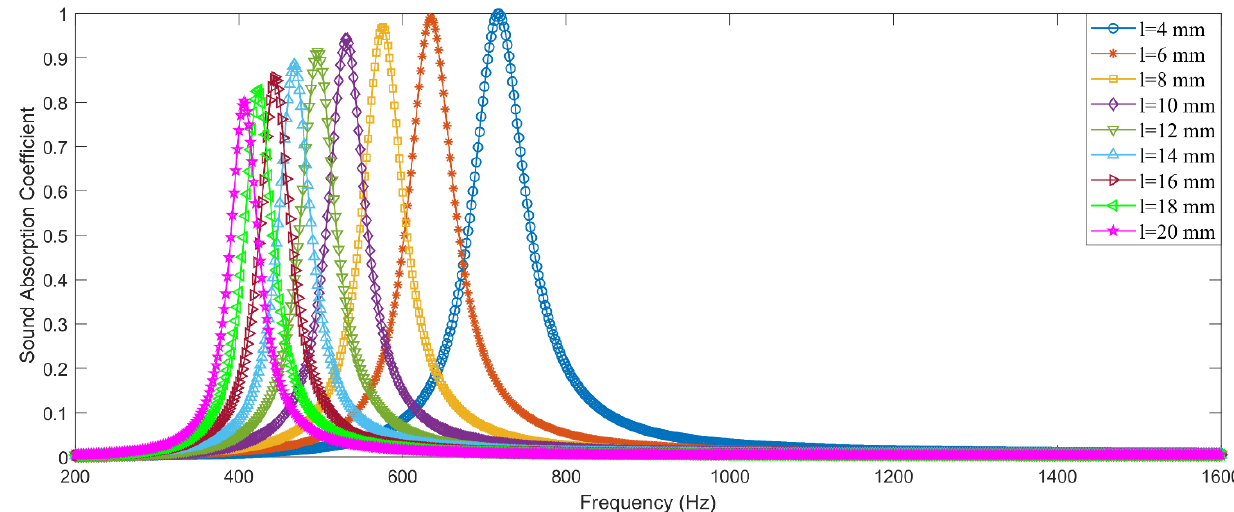
Figure 4. Distributions of theoretical sound absorption coefficients of single resonator along with increase in length of the aperture obtained by two–dimensional equivalent simulation model.